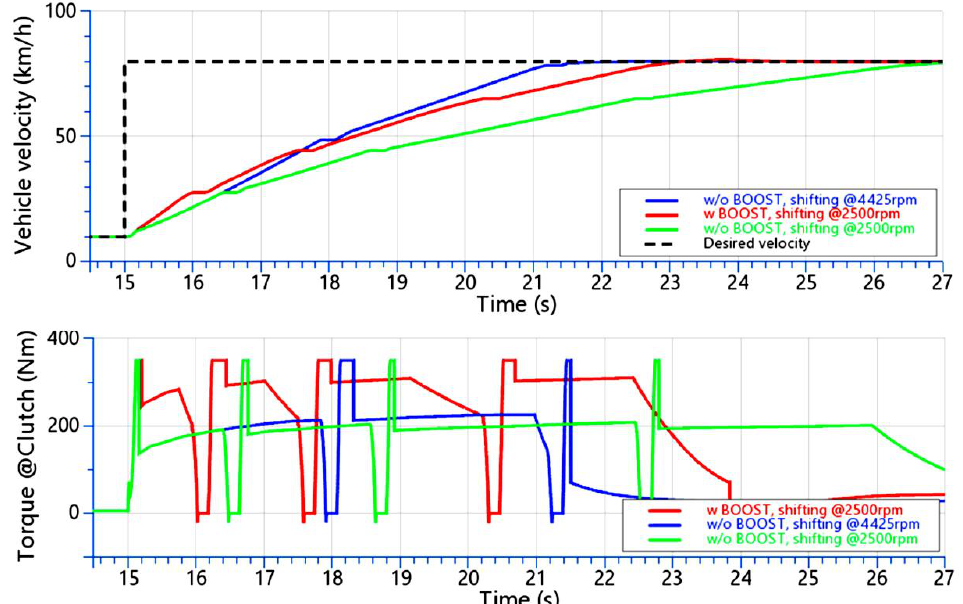
Figure 17. Comparative CRUISE TM M simulation results without BSG-based torque boosting and with BSG-based torque boosting included [10].